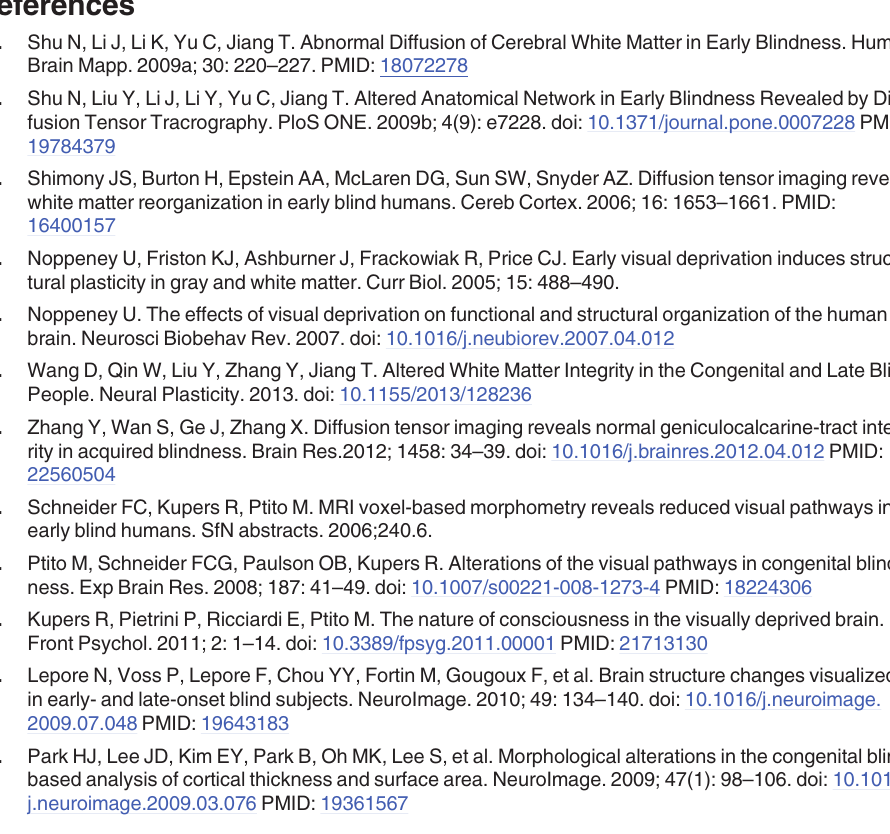
blind ” (two sample t -test). Results were exposed at a threshold of p < 0.05, family wise error (FWE)